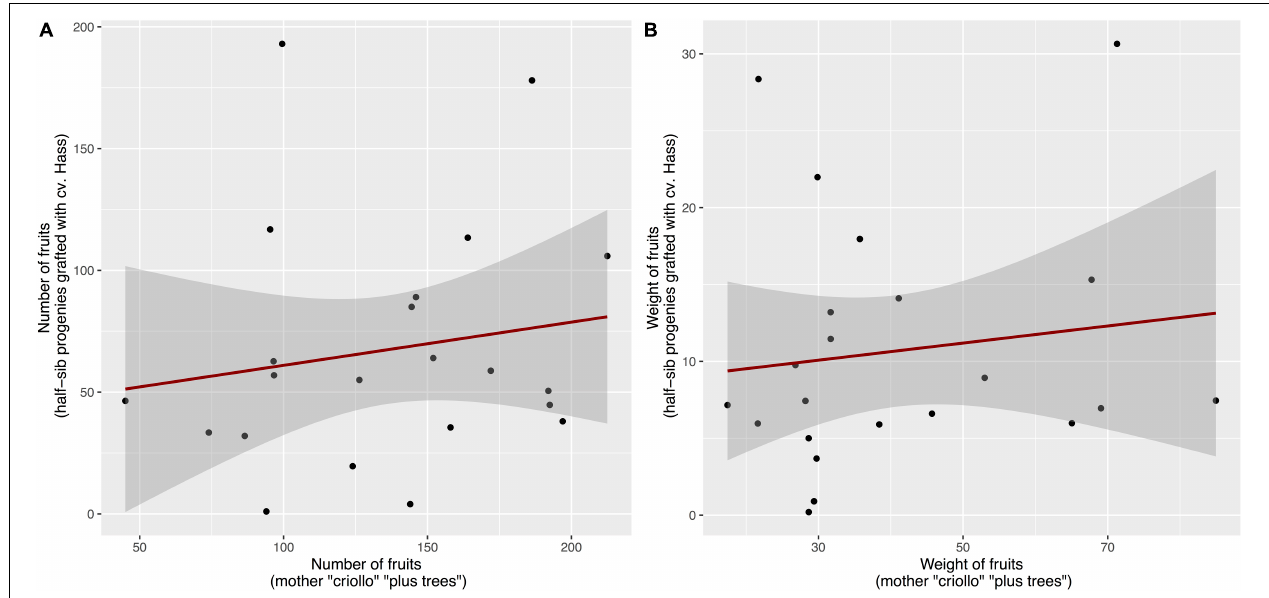
FIGURE 7 | Mother-offspring regressions used to quantify the rootstock-mediated h 2 scores for cumulative (A) number of fruits and (B) weight of fruits from the Hass clone grafted on OP half-sib seedling progenies of selected avocado “criollo” “plus trees.” The h 2 score is computed as twice the slope from the mother-offspring regression (Lynch and Walsh, 1998), and was 0.36 and 0.11 h 2 for number of fruits and weight of fruits,